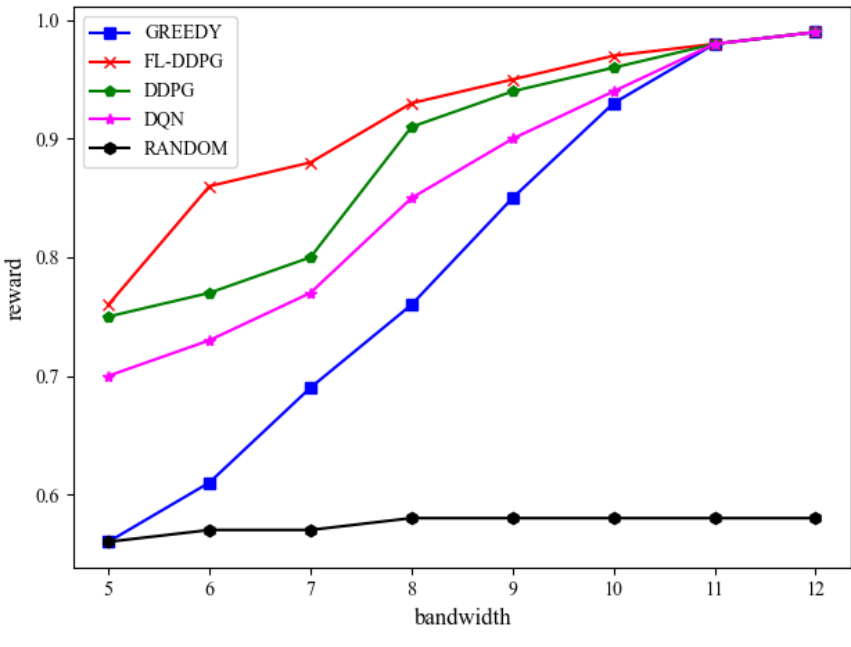
Figure 5. Performance evaluation on reward.